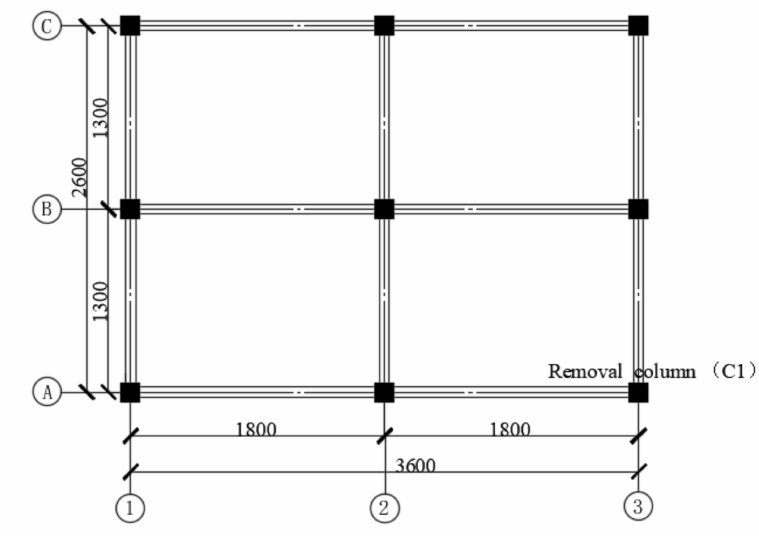
Figure 1. The typical two floor plan of the RC frame substructure.